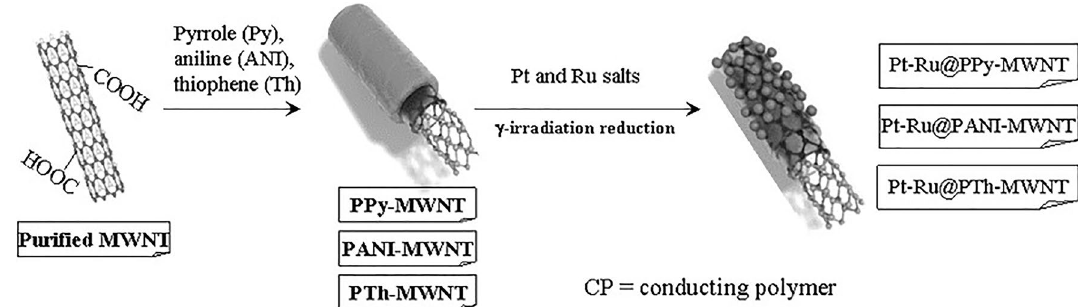
Fig. 7 Preparation procedure for Pt-Ru@MWNT catalyst by various reduction method for fuel